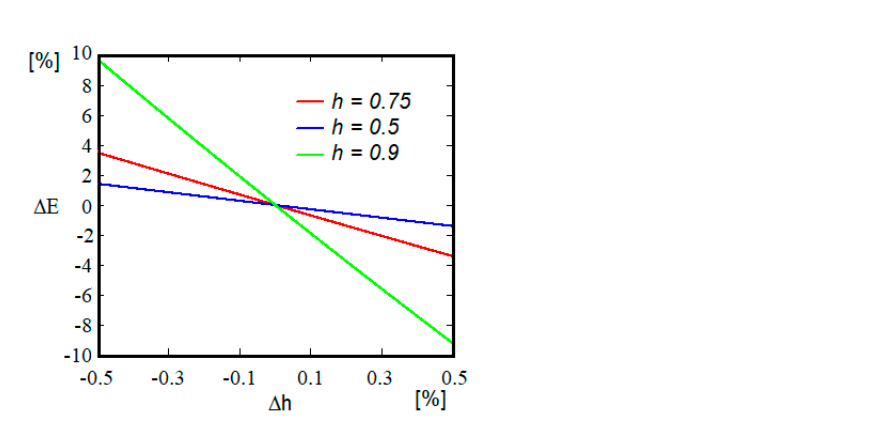
5 of 15 Figure 1. Transformation of a single-step elastic pulse into a multi-step elastic pulse when passing through a sample with a different mechanical impedance than the bars. Processing the recorded data from such a test is limited to the determination of the dimensionless value h which faithfully reproduces the ratio between the heights of two successive steps from the signal recorded by a strain gauge placed on the transmission bar. For this reason, the classic data processing procedures used in SHPB tests are not necessary. Using (10) and the value of the experimentally determined constant h , the mod- ulus of elasticity of the sample is calculated as: